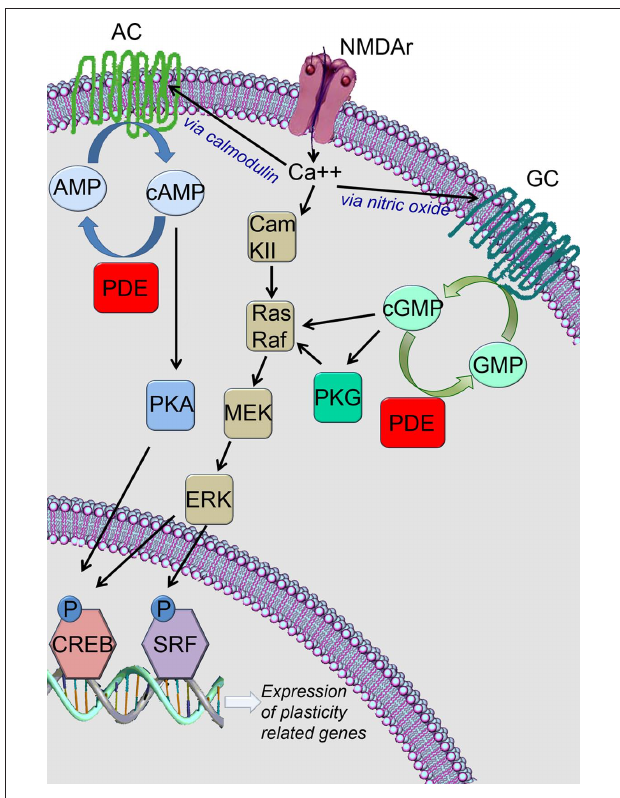
plasticity-related genes. AC, adenyl cyclase; GC, guanylate cyclase; CREB, cAMP responding element binding protein; SRF, serum response factor.